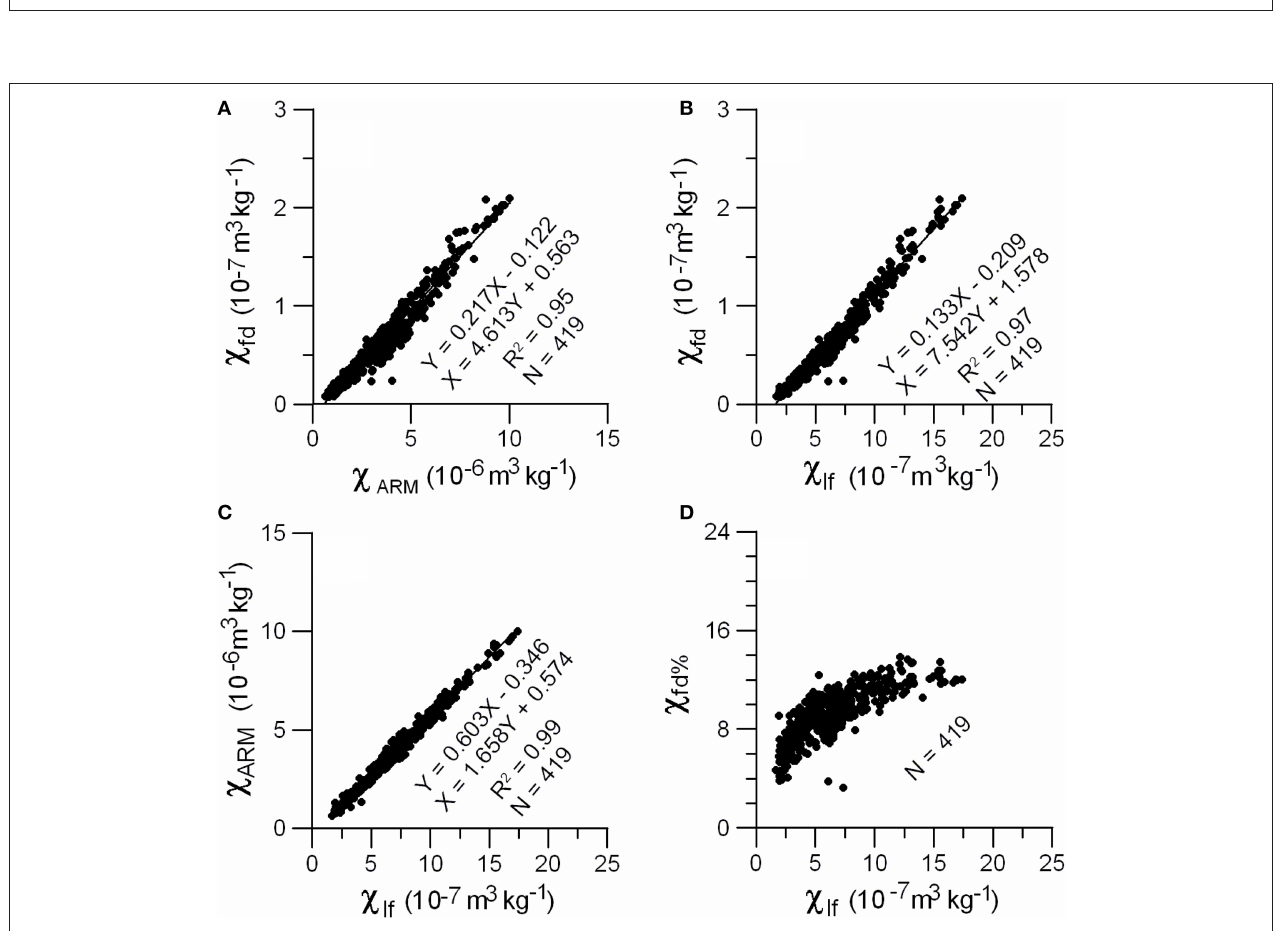
FIGURE 3 | The relationship (Nie et al., 2007) between χ ARM vs. χ fd (A), χ lf vs. χ fd (B), χ lf vs. χ ARM (C), and χ fd vs. χ fd % (D) in the lower section of the Chinese loess-paleosol sequence from Chaona. χ fd % = ( χ 470Hz − χ 470Hz )/ χ 470Hz × 100. Modified from Nie et al. (2007).